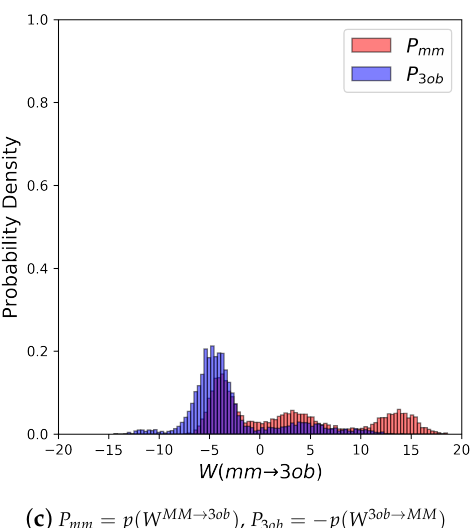
Figure 12. ( a ) Molecule 9 ’s potential energy “forward” ( P mm ) and “backward” ( P 3 ob ) distributions plotted as “offset” from the ∆ U MM → 3 ob to simplify the x-axis. ( b ) Molecule 9 ’s nonequilibrium work “forward” ( P mm ) and “backward” ( P 3 ob ) distributions from 1 ps switching simulations plotted as “offset” from the W MM → 3 ob to simplify the x-axis. ( c ) Molecule 9 ’s nonequilibrium work “forward” ( P mm ) and “backward” ( P 3 ob ) distributions from 5 ps switching simulations plotted as “offset” from the W MM → 3 ob to simplify the